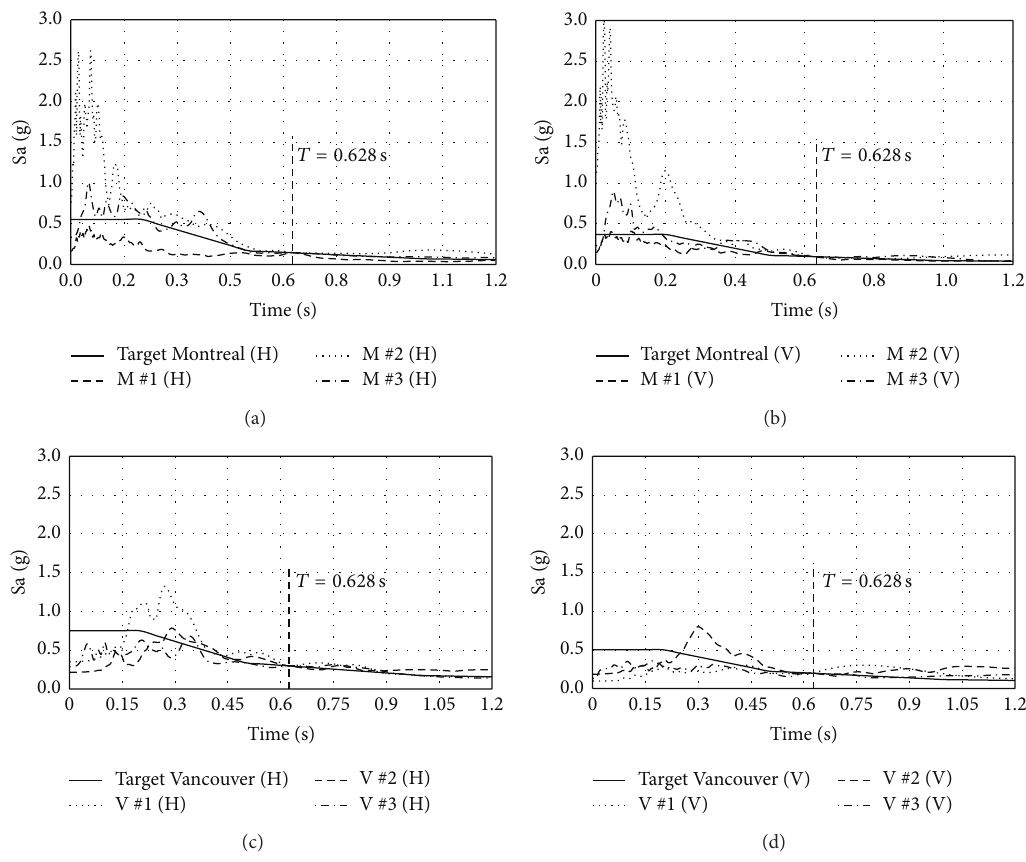
Figure 5: Response spectra for the ground motion records: (a) Montreal-horizontal components, (b) Montreal-vertical components, (c) Vancouver-horizontal components, and (d) Vancouver-vertical